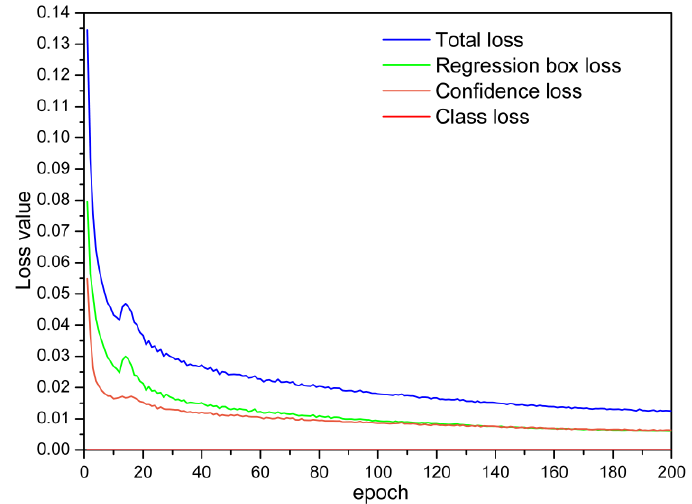
Figure 8. Change trends of the loss functions during the training process.